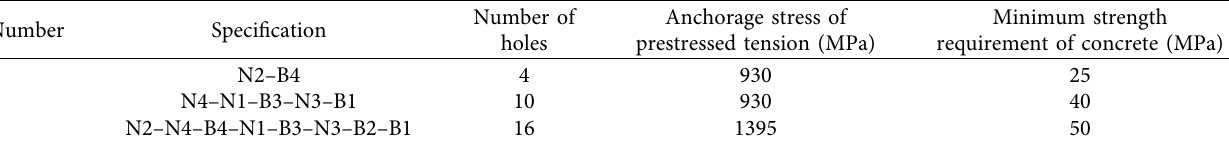
Table 4: The control parameters for three-stage construction of prestressed